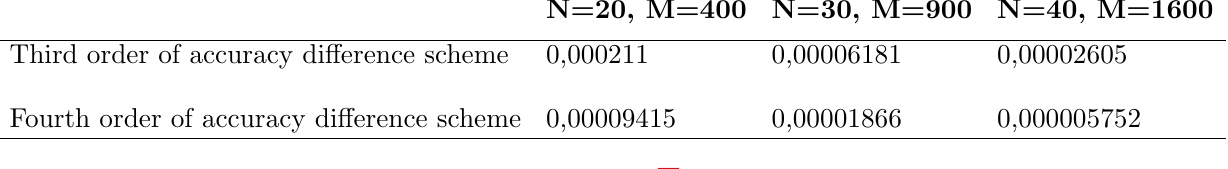
Table 2. CPU times for the approximate solutions of (8).